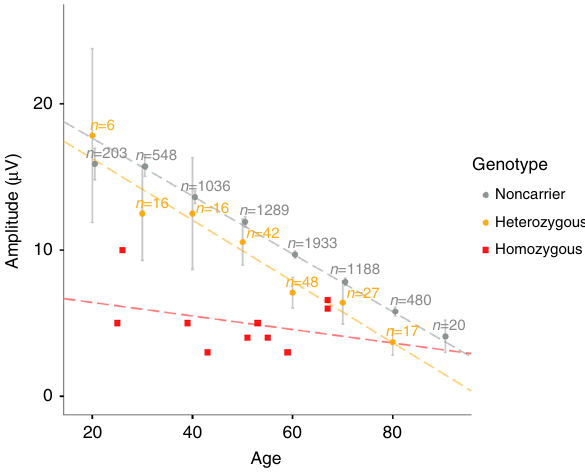
Fig. 2 Sural nerve action potential (SNAP, μ V) decreases with age ( N = 6879). Shown is the mean SNAP per age group among non-carriers (gray dots) and heterozygotes (orange dots). Gray vertical lines represent 95% con fi dence intervals for the means. The red squares show individual values for the 10 homozygotes. The dotted lines represent results from a linear regression; SNAP (amplitude, μ V) = β 0 + β 1 × Age, for each genotype group. Non-carriers: N = 6697; SNAP = 21.6 − 0.20 × Age; R 2 = 0.19; P = 1.2 × 10 − 303 . Heterozygotes: N = 172; SNAP = 20.4 – 0.21 × Age; R 2 = 0.29; P = 1.9 × 10 − 14 . Homozygotes: N = 10; SNAP = 7.3 − 0.05 × Age; R 2 = 0.12; P = 0.33. Source data are provided in a Source Data fi le